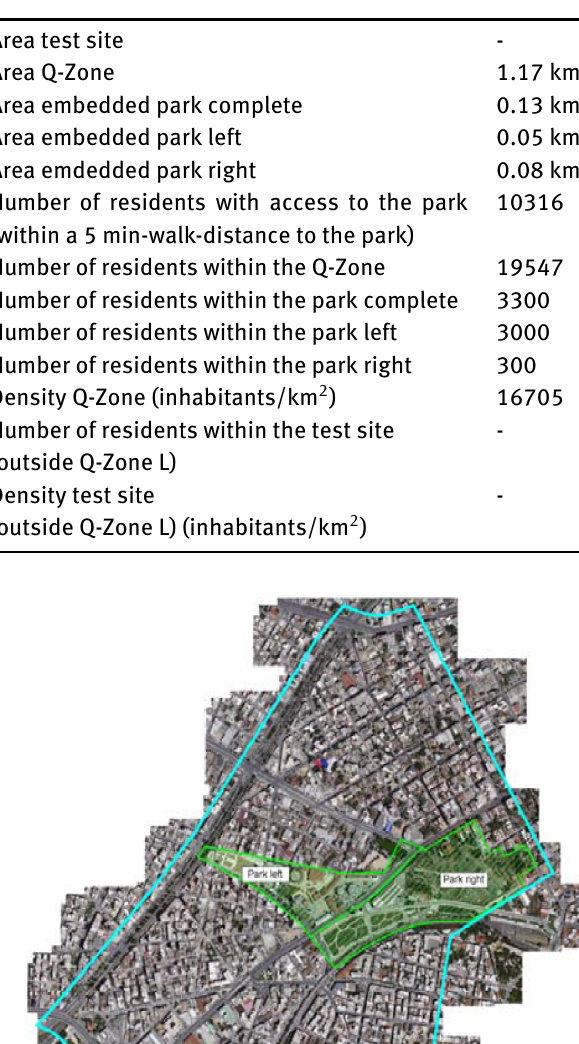
Table 1: Test-site-describing attributes for Athens. Q-Zone test site.